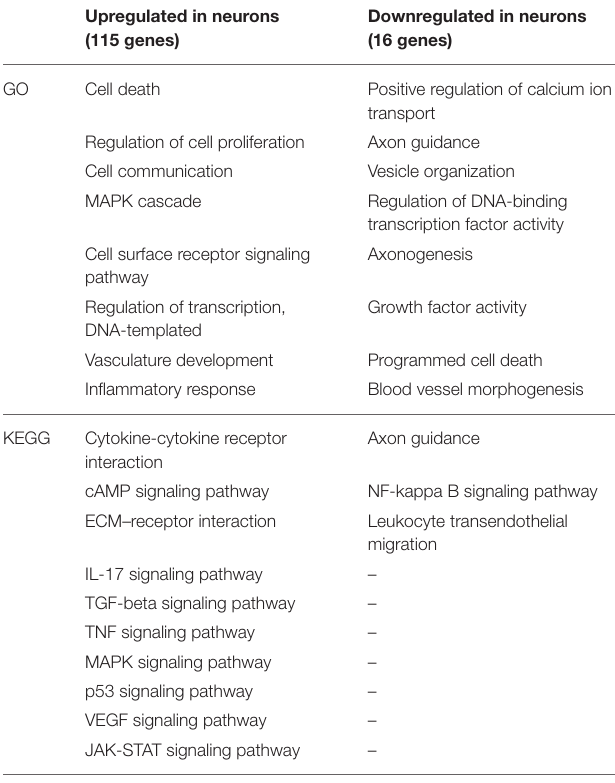
TABLE 3 | Selection of relevant Gene Ontology (GO) and Kyoto Encyclopedia of Genes and Genomes (KEGG) terms of the differentially expressed genes in neurons in the contralateral hippocampus (CLH) at 24h after kainate-induced status epilepticus. Upregulated in neurons (115 genes) Cell death